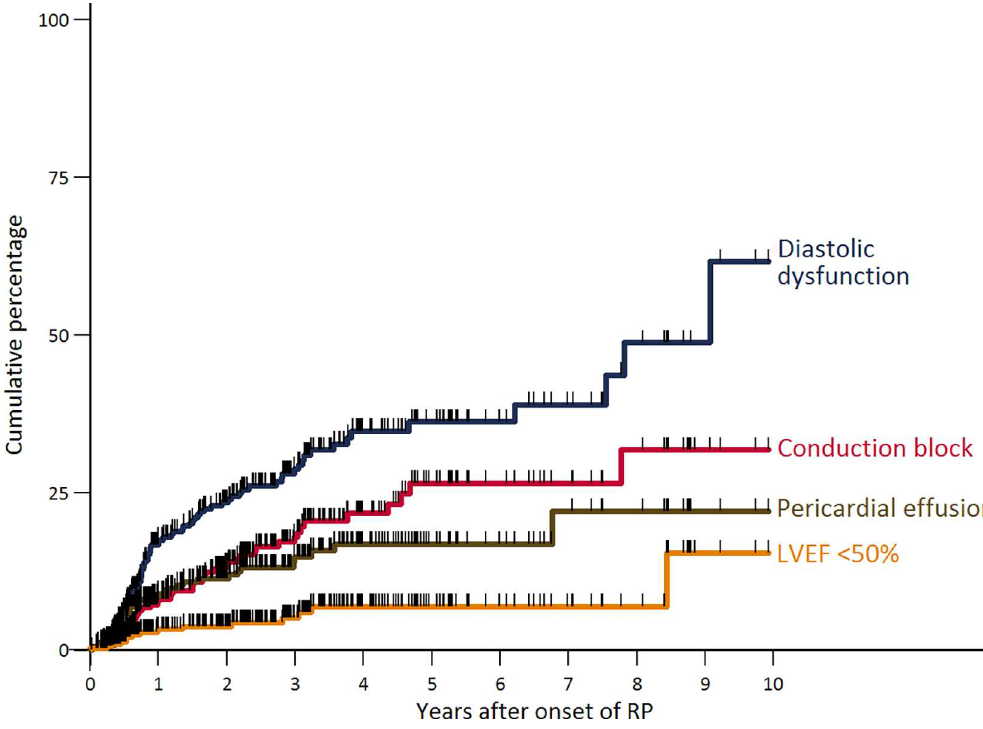
Fig 5. Kaplan-Meier curves of incident cardiac manifestations after RP onset in SSc in the study population. RP, Raynaud’sphenomenon; Pts, patients; LVEF, left ventricular ejection fraction; hash marks represent censored